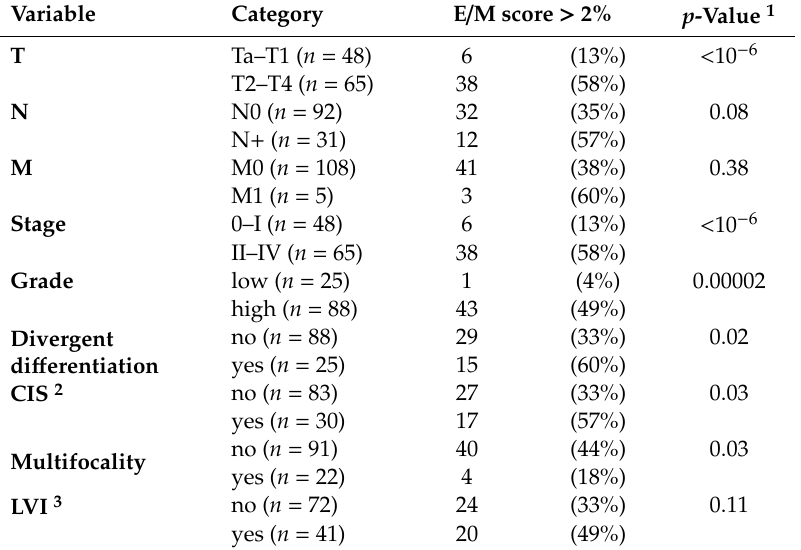
Table 1. Relations between the presence of hybrid E / M cancer cells and clinicopathological variables.